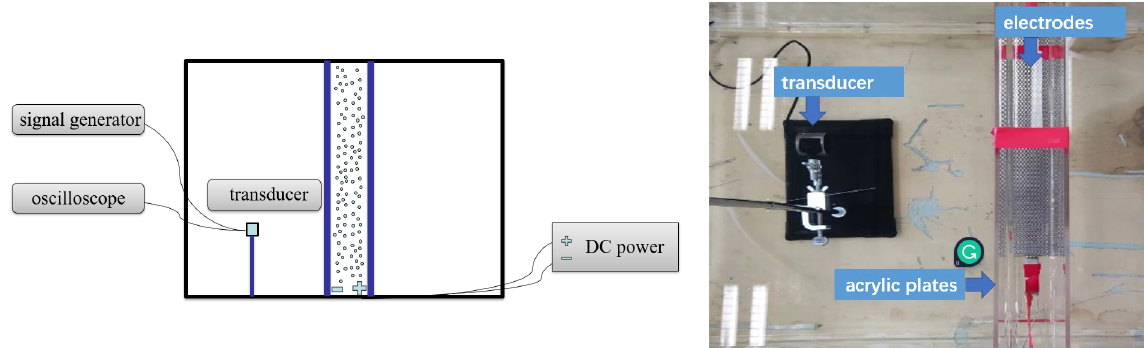
Figure 7. Experimental setup diagram.